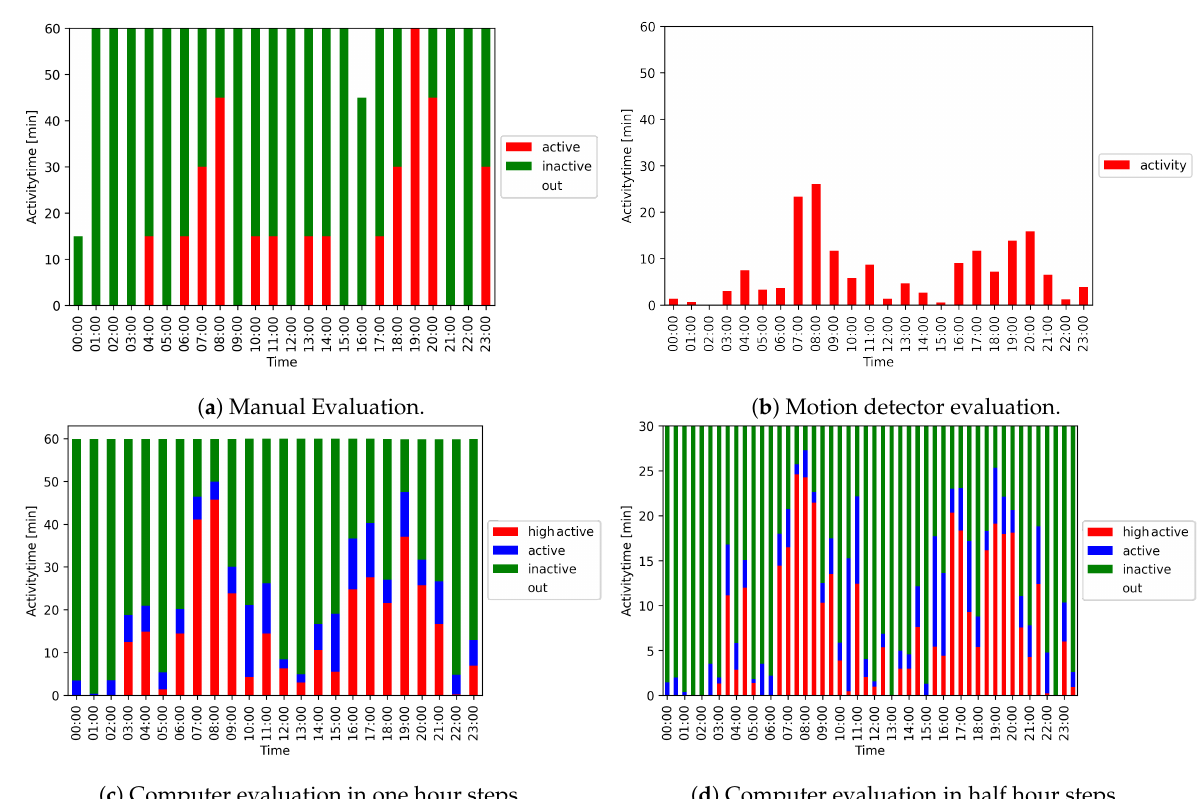
Figure 11. 24-h activity overview of a fox using different evaluation